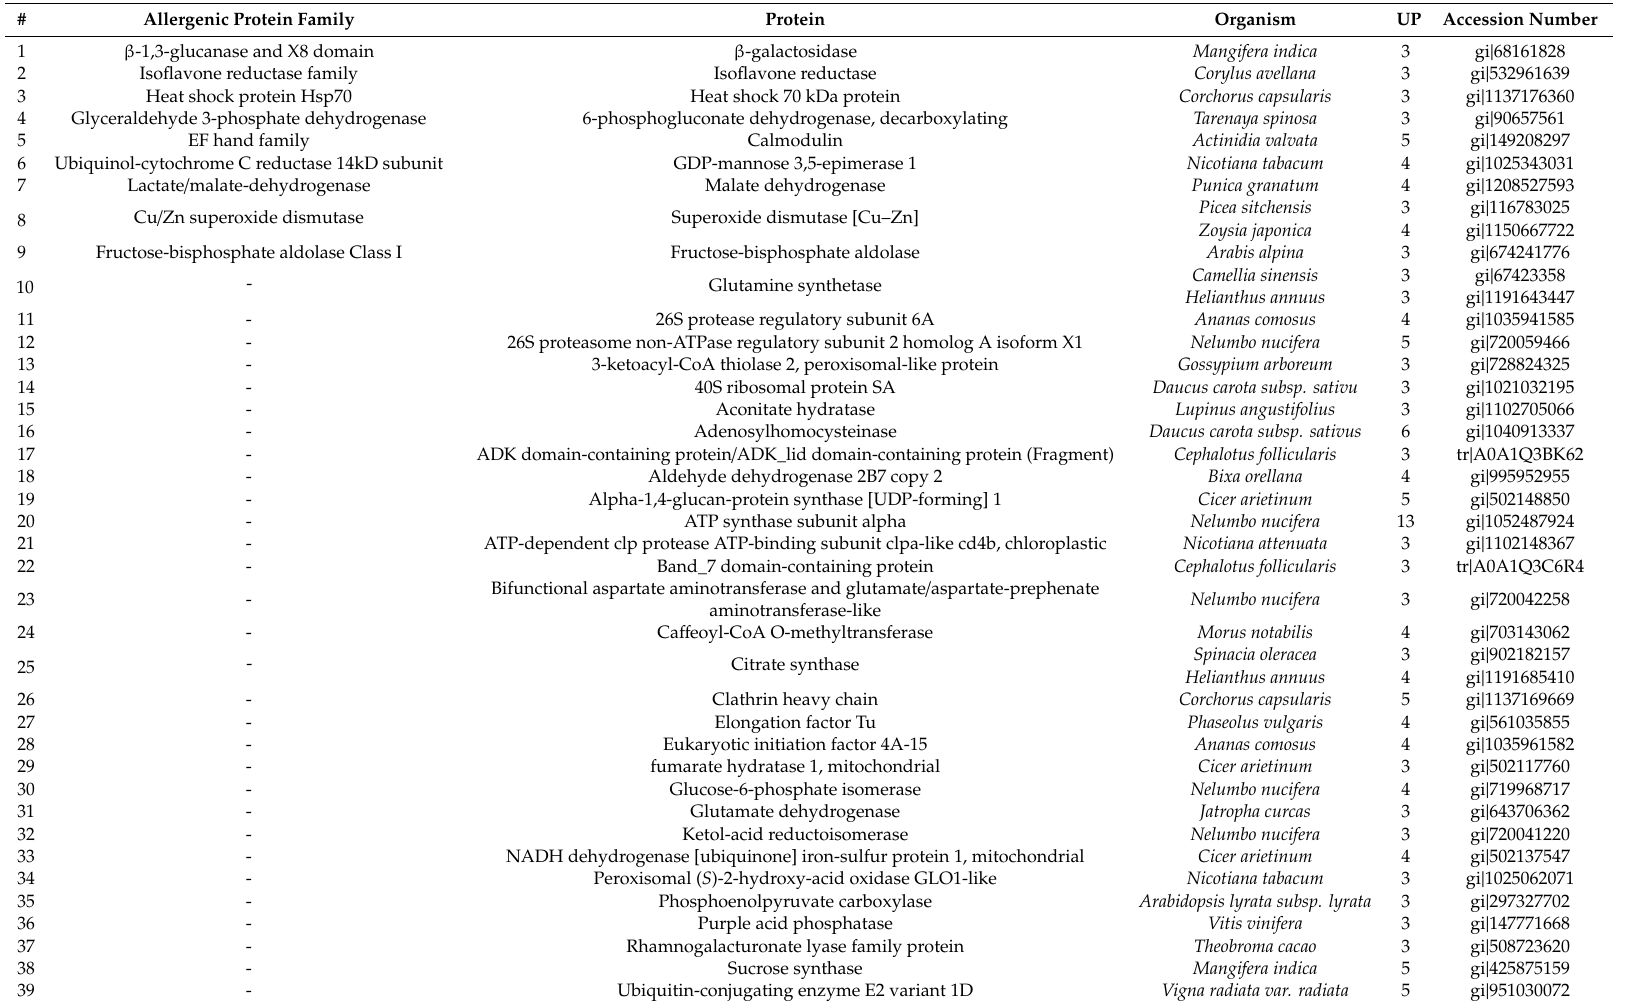
Table 1. Allergenic protein families and proteins identified in cashew tree pollen by shotgun